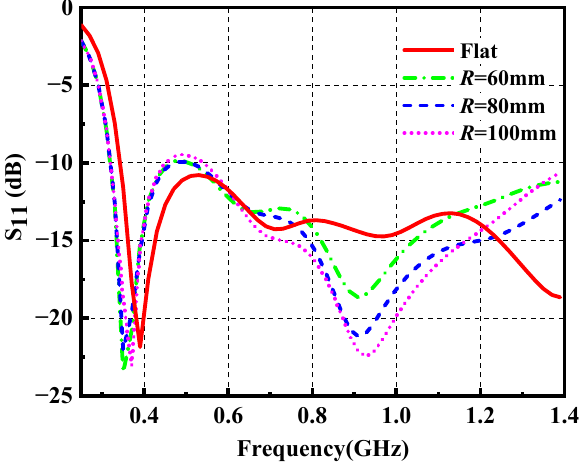
Figure 8. Reflection coefficient of the wearable antenna under flat and bending states.